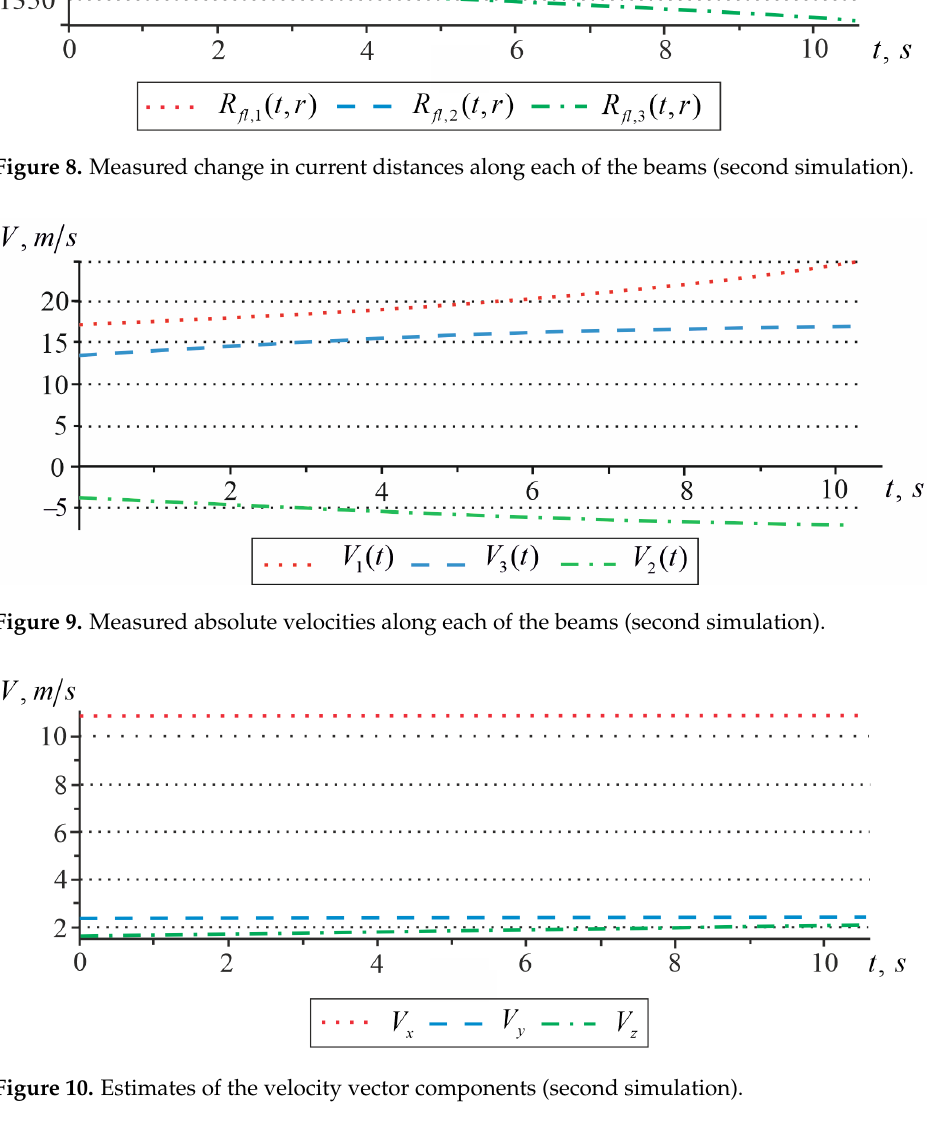
Figure 10. Estimates of the velocity vector components (second simulation).